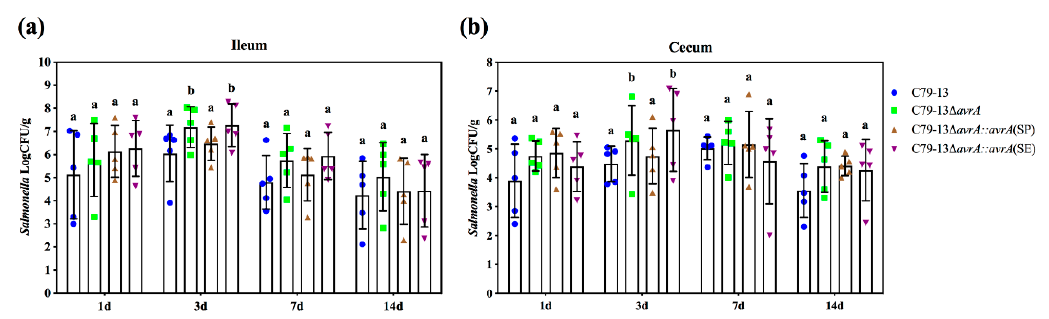
Figure 7. SP-AvrA dampen colonization and dissemination of S. Pullorum in mucosal tissues of chicken. Four-day-old HY-Line chickens were infected with S. Pullorum strains, and the bacteria from ileum ( a ) and cecum ( b ) were counted on MacConkey agar media plates at 1, 3, 7, and 14 days post infection. Data are expressed as the mean ± SD. The different letters on the error bars indicate statistically significant differences ( p < 0.05).